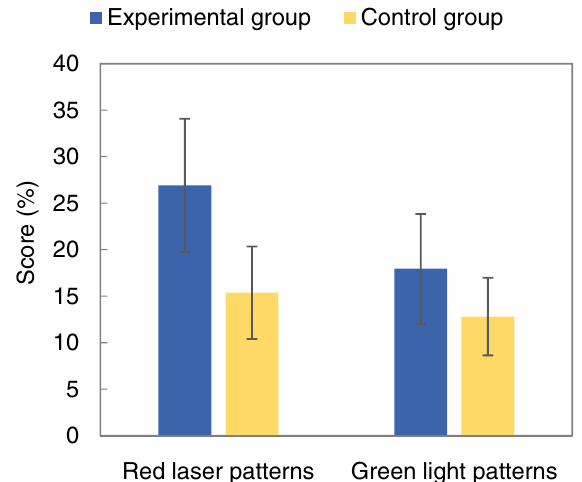
FIG. 4. Mean scores of students in the experimental and control grouponquestionsregardingredlaserpatternsandgreenlightpatterns. The error bars represent 1 standard error of the mean